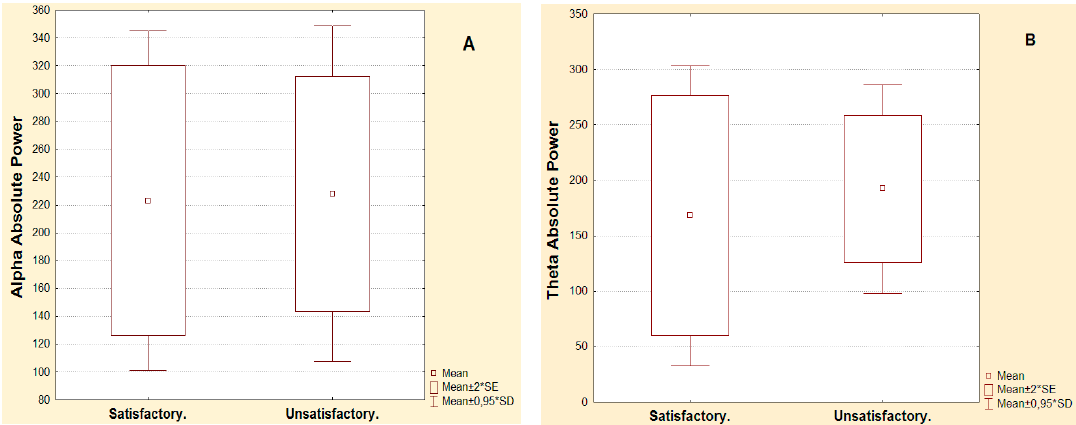
Figure 1. Patients in pre-surgical phase; regroup according to the evolution achieved in the second year of surgical intervention. ( A ) Alpha absolute power. ( B ) Theta absolute power. Mann Whitney.